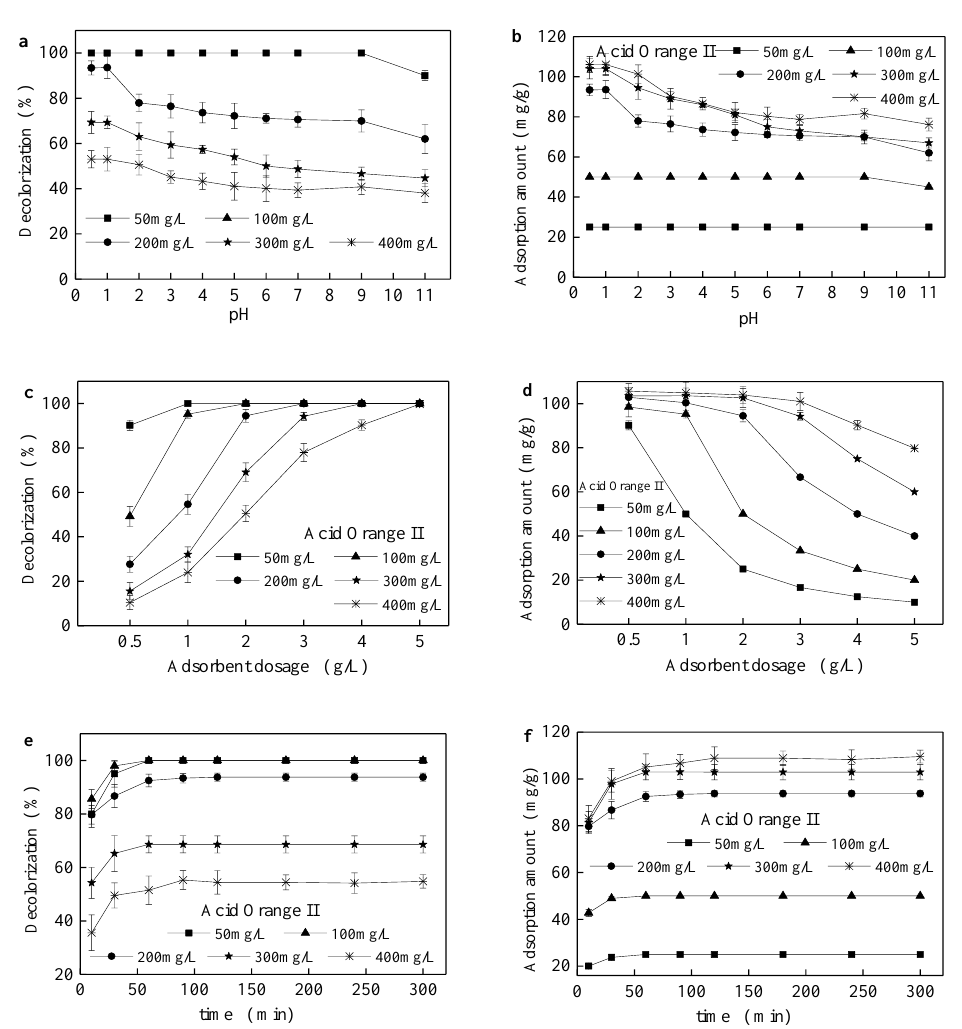
Figure 4. E ff ect of pH, adsorbent dosage and adsorption duration on the Acid Orange II adsorption performance. In ( a , b ), the adsorption test was conducted with 2 g / L modified sepiolite for 120 min under an oscillation rate of 180 r / min and 25 ◦ C; in ( c , d ), the adsorption test was conducted for 120 min under initial pH value of 1, an oscillation rate of 180 r / min and 25 ◦ C; in ( e , f ), the adsorption test was conducted with 2 g / L modified sepiolite under an oscillation rate of 180 r / min, an initial pH value of 1 and 25 ℃ .